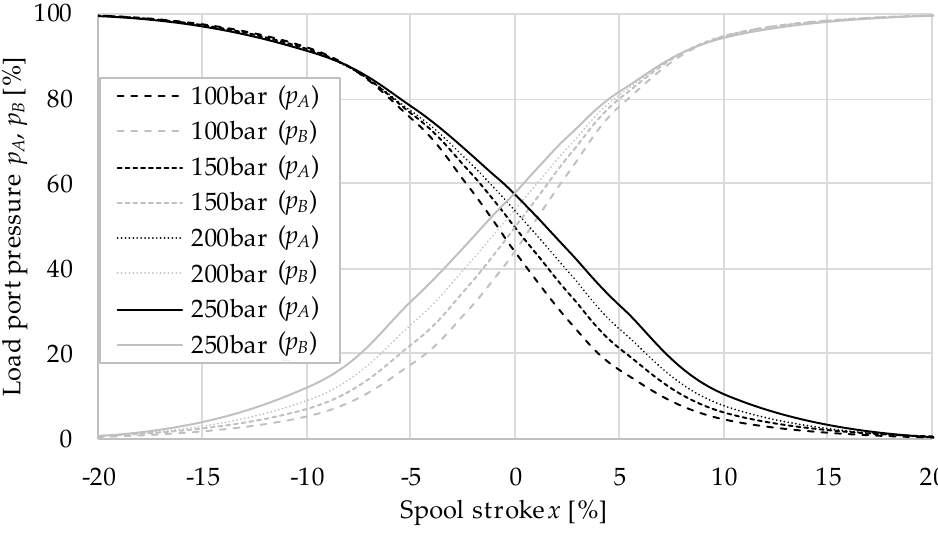
Figure 6. Blocked-line pressure sensitivity curves for different supply pressures.